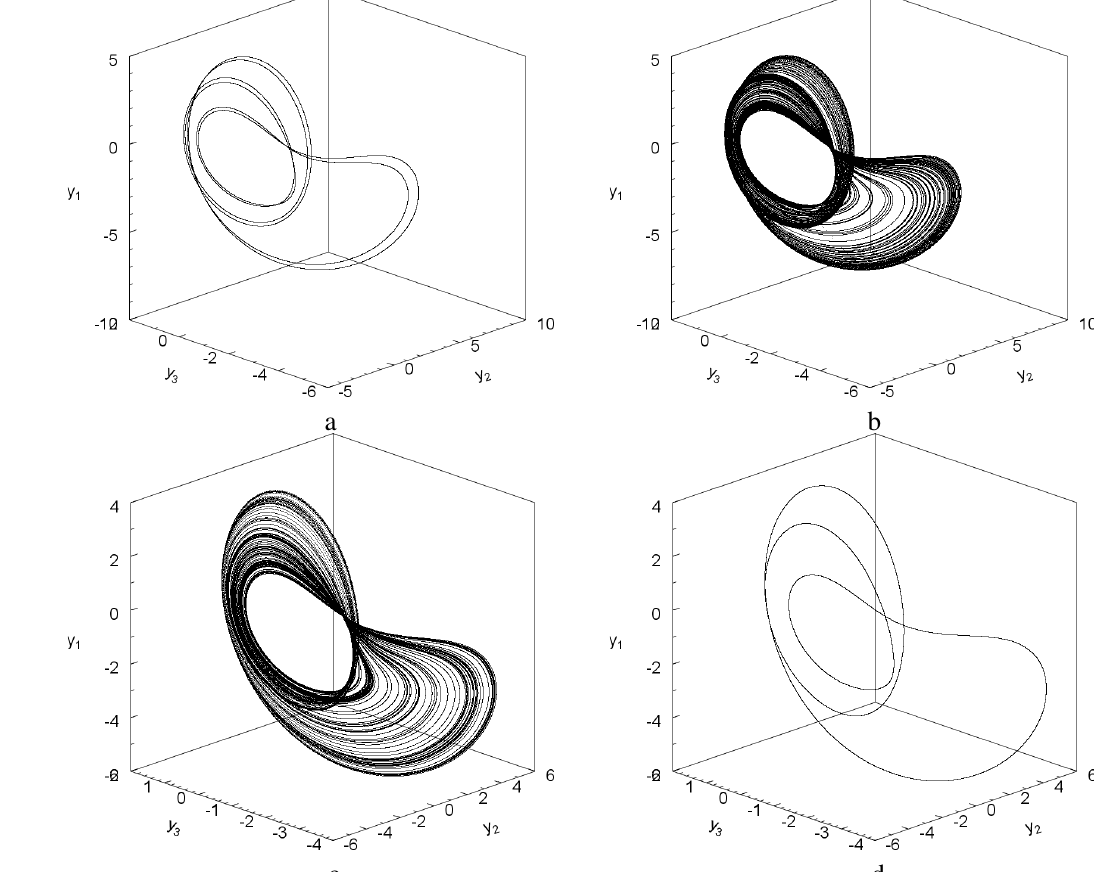
Fig. 4 Phase portraits of attractors of the system (4) (a), (c) and the system (5) (b),